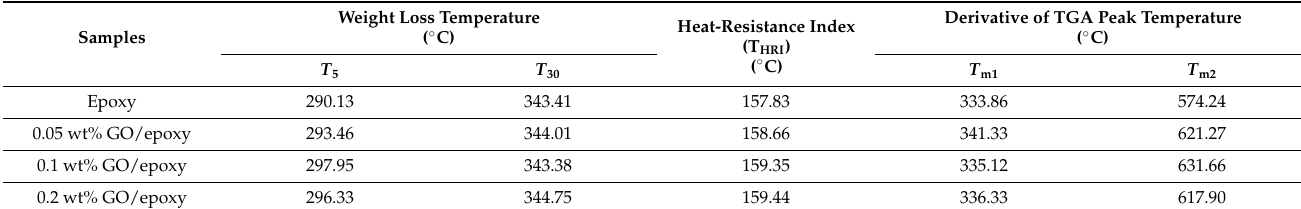
Table 1. TGA properties of pristine epoxy and different weight percentages of nanocomposites. Samples